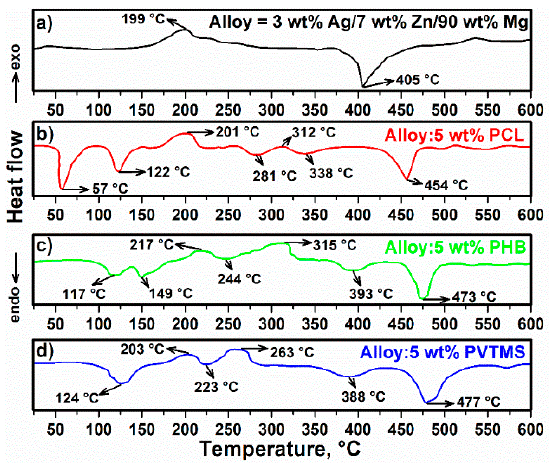
Figure 2. DSC curve of ( a ) alloy, ( b ) C1, ( c ) C2 and ( d ) C3.